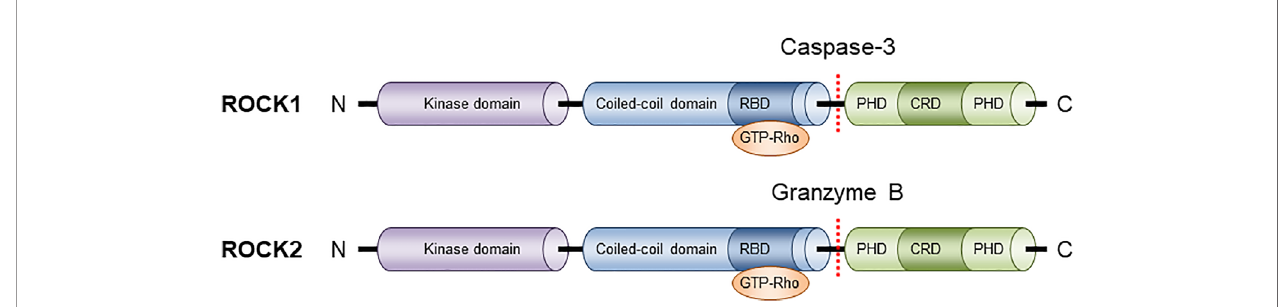
FIGURE 1 | Structure of ROCK isoforms. ROCK1 and ROCK2 are known as ROK b and ROK a respectively. Both isoforms consist of three major domains: a kinase domain in the N-terminal domain, a coiled-coil domain that contains a Rho-binding domain (RBD), and a putative pleckstrin homology domain (PHD) at its C-terminal